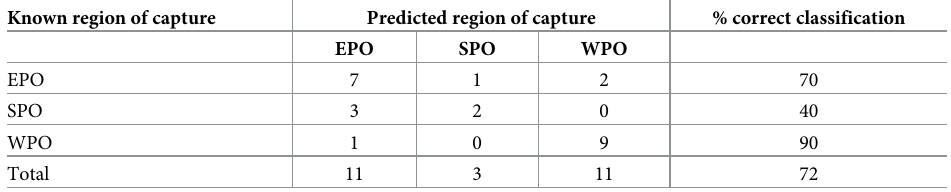
Table 3. Jackknifed classification success to the three regions (EPO, WPO, SPO) derived from quadratic discrimi- nant function analysis based on otolith edge element:Ca values of Pacific bluefin tuna. Known region of capture